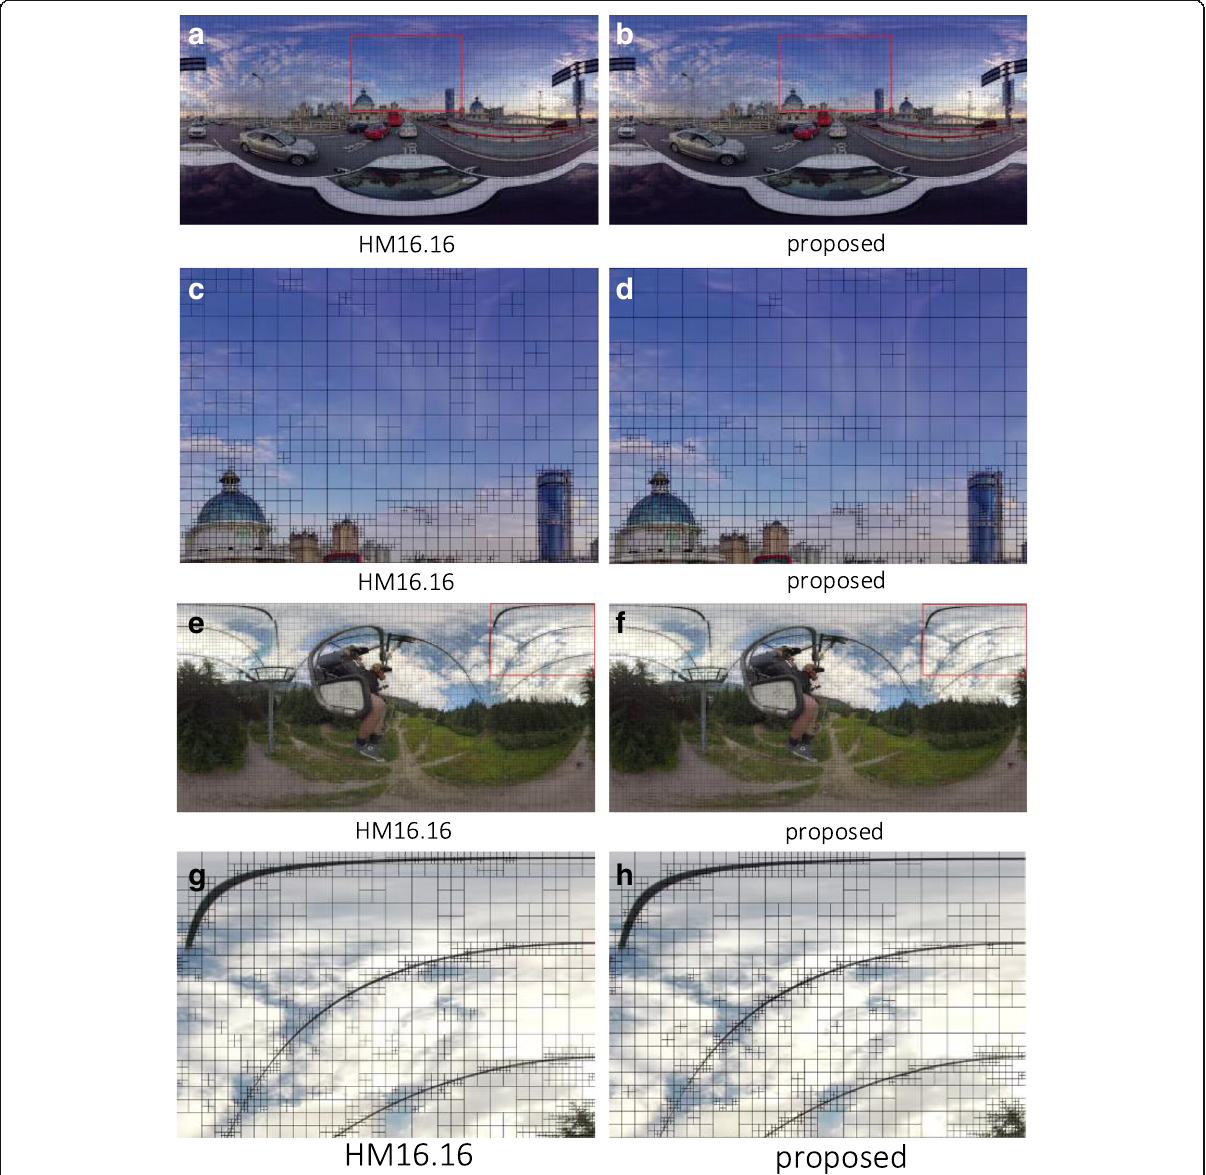
Fig. 11 Comparison of CU partition line images of the proposed algorithm and HM 16.16. a , e CU partition line image of HM 16.16. b , f CU partition line image of the proposed algorithm. c , g Partially enlarged CU partition line image of HM 16.16. d , h Partially enlarged CU partition line image of the proposed